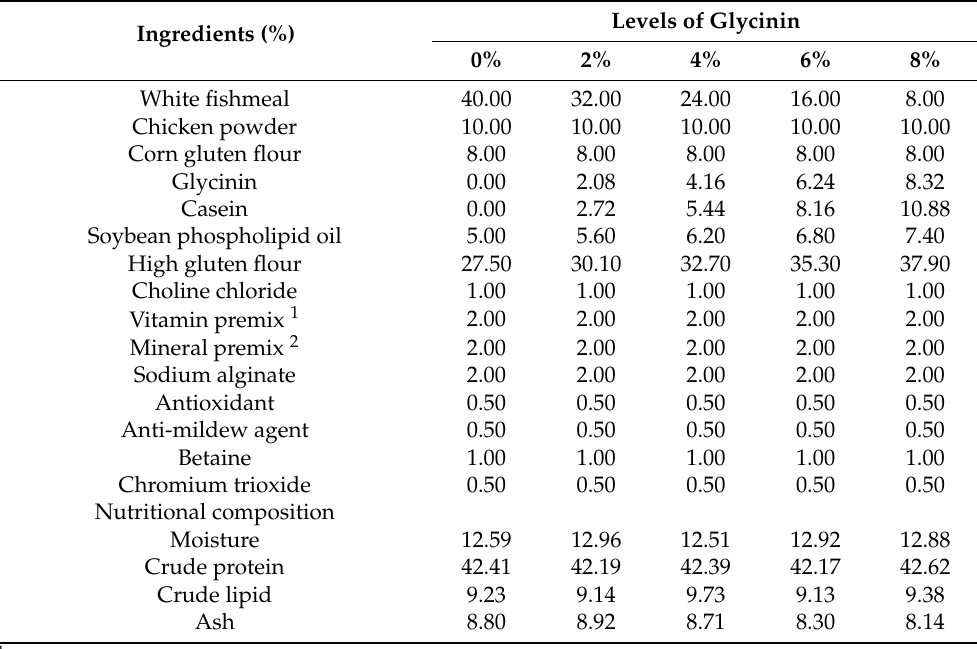
Levels of Glycinin